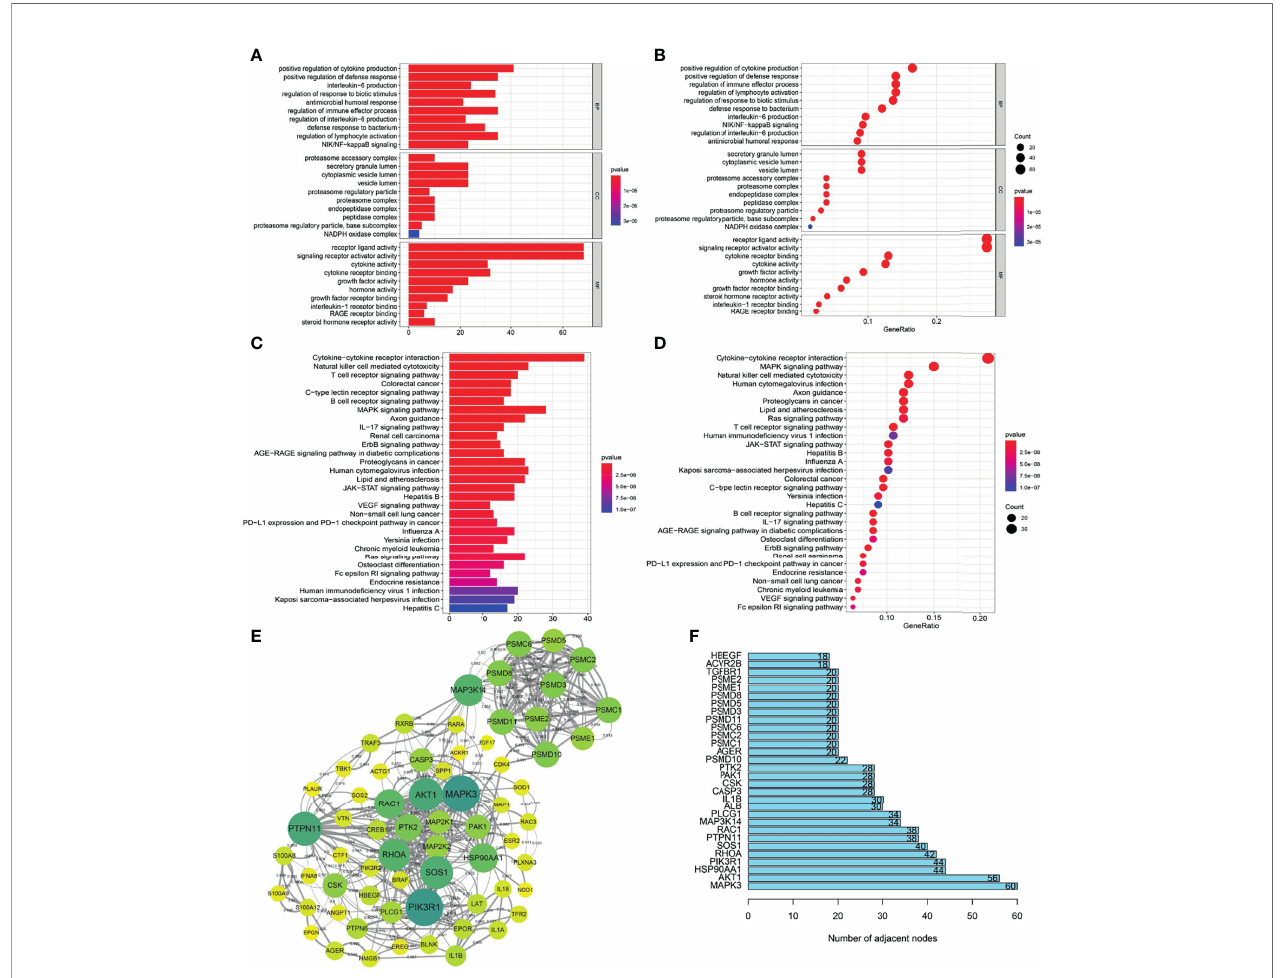
FIGURE 4 | Screening and functional analysis of immune genes highly related to METTL3. (A, B) GO analysis of METTL3 -related immune genes. (C, D) KEGG analysis of METTL3 -related immune genes. (E) Protein-protein interaction network analysis of METTL3 -related immune genes (high con fi dence 0.700; only some core genes were displayed; the larger the circle, the darker the color, representing the more adjacent nodes). (F) The core genes of the protein-protein interaction network (showing only the top